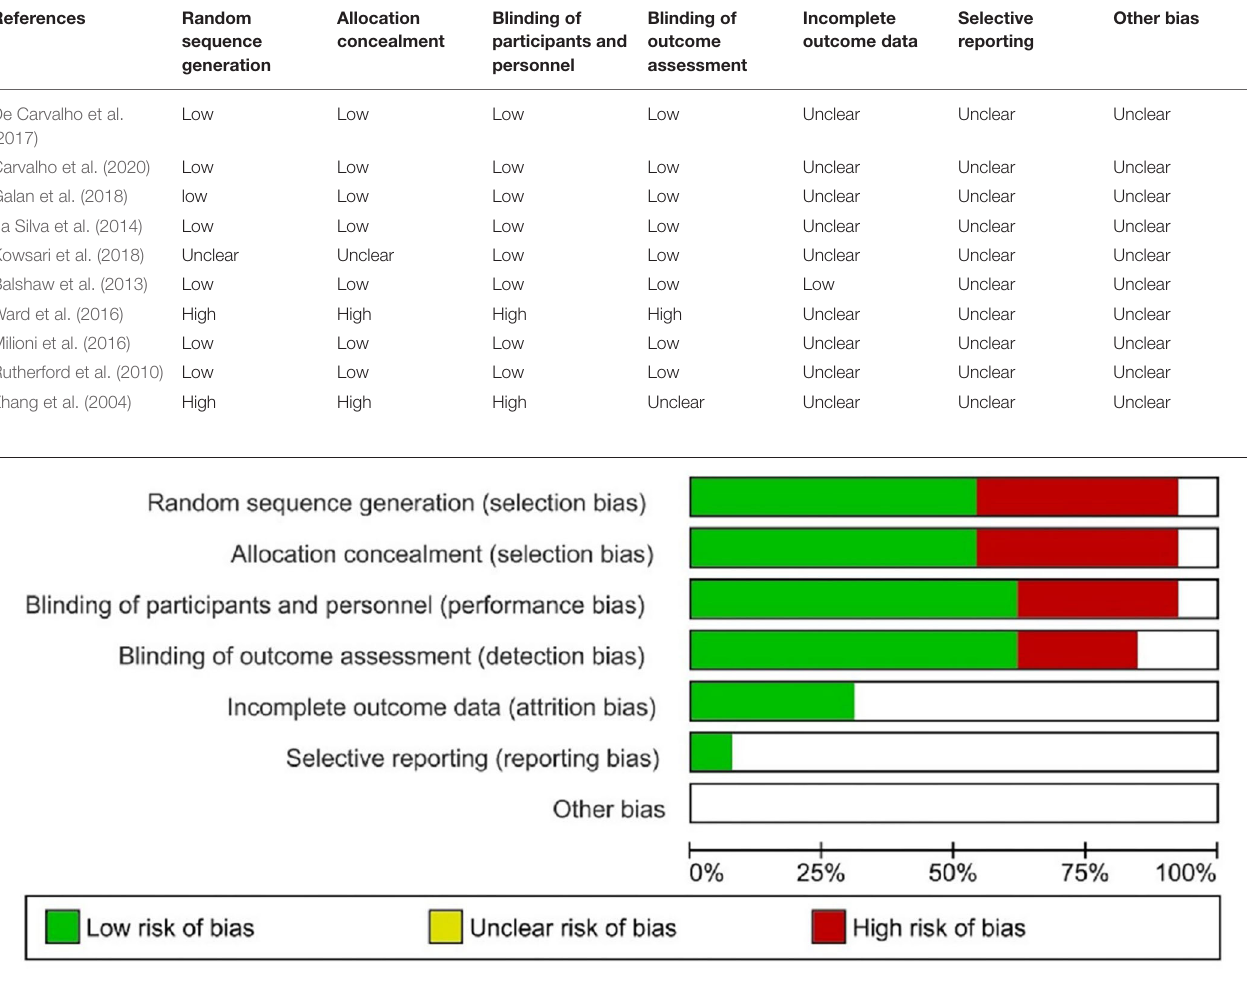
FIGURE 2 | Risk of bias evaluation of included